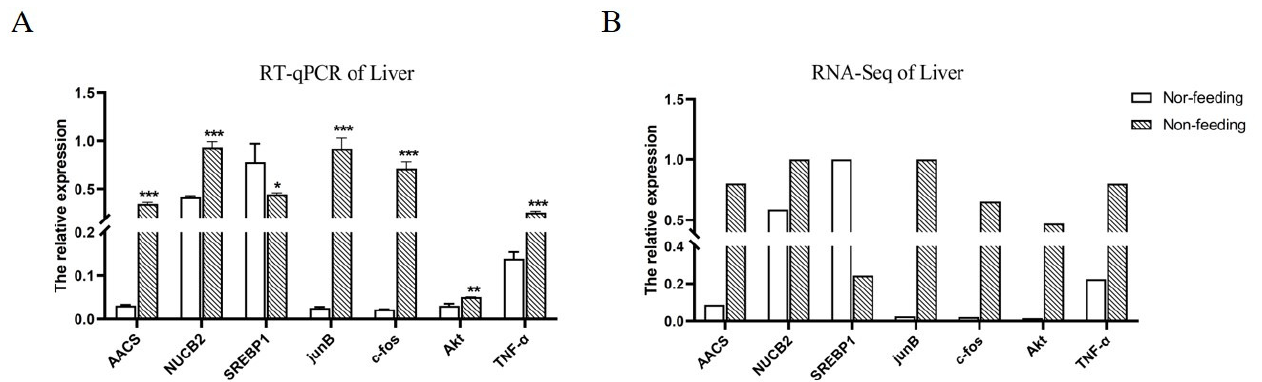
Figure 5. Part of DEGs were verified by RT-qPCR. Gene-expression levels were normalized to that of β -actin and EF1- α . Data are presented as the group means ± SD ( n = 5). Statistical comparison of the mRNA levels detected in different groups was carried out by t -test of variance (* p < 0.05, ** p < 0.01, *** p < 0.001). ( A ) RT-qPCR of liver; ( B ) RNA-Seq of liver.